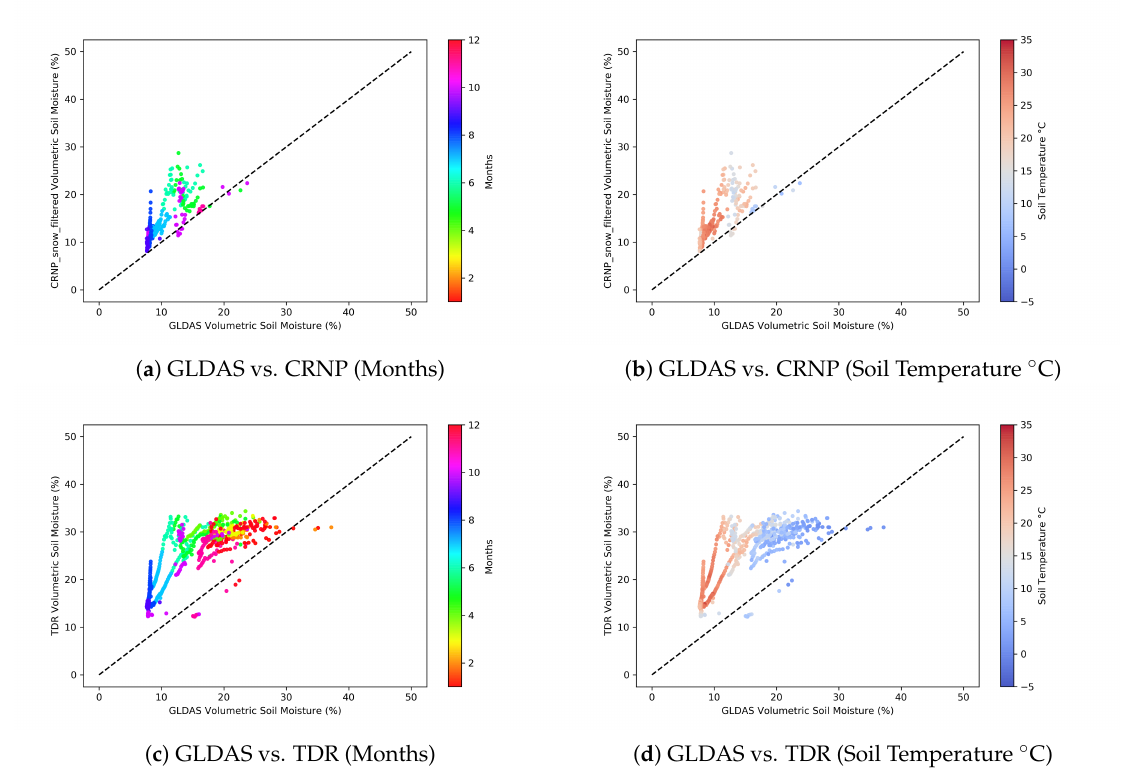
Figure A7. Comparisons between GLDAS Soil Moisture Product with CRNP and TDR.